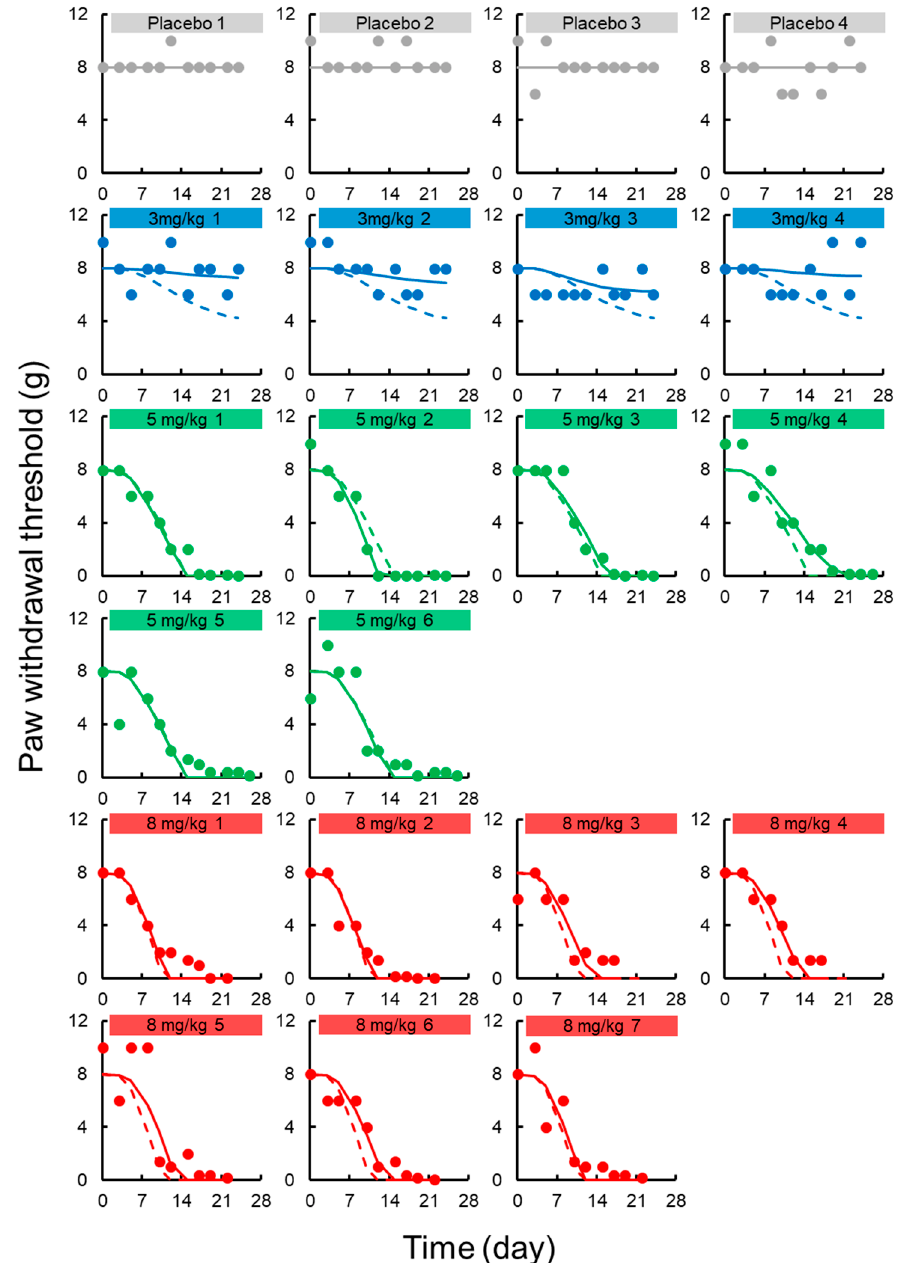
Figure 5. Individual paw withdrawal threshold in the von Frey filament test vs. time profiles after intravenous administration of oxaliplatin (L-OHP) to rats. Each circle represents the observed paw withdrawal threshold in the von Frey filament test, with a fitted solid line depicting the individual paw withdrawal threshold predicted by the PK-TD model and a dashed line showing the population fits.